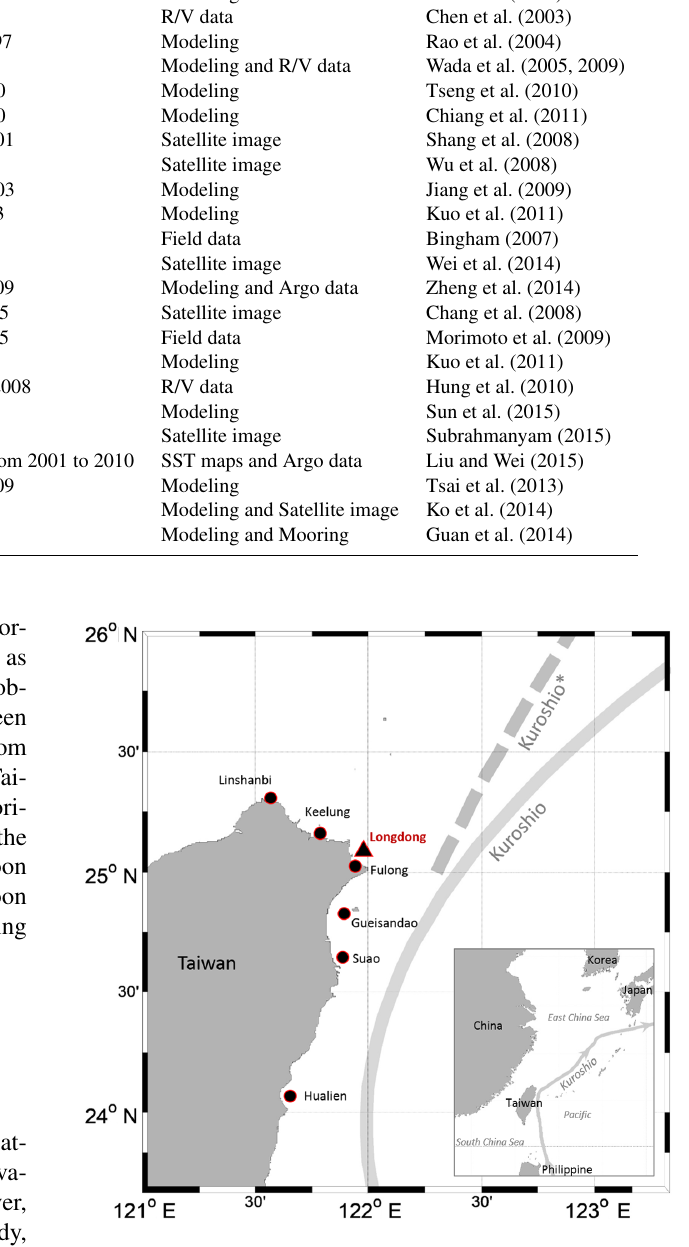
Figure 1. Locations of the study area and field stations. The gray belt is the main stream of Kuroshio; however, the dashed gray belt is the shift of the Kuroshio during Typhoon Haitang in 2005 according to measurements by Morimoto et al.